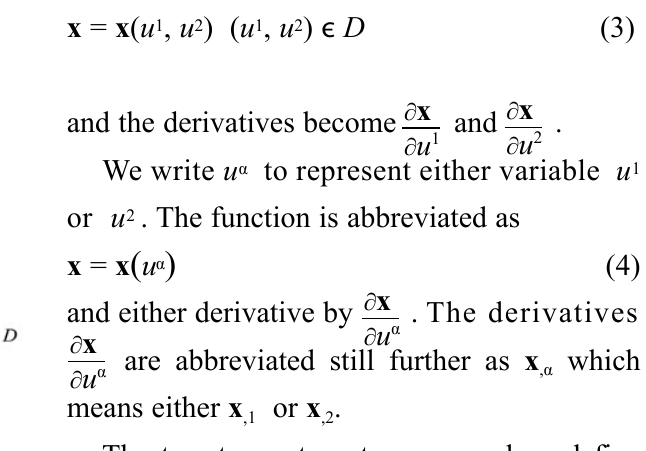
Figure 1 Graphical representation of a vector function of two variables (equation 1). The function generates a surface in space. Along the curve labelled v the parameter v is fixed and parameter u varies; it is a u- parameter curve. Similarly along the curve labelled u parameter u is fixed; it is a v- parameter curve. The surface has two families of curves, the u- and the v- parameter curves. x is the position vector of the point on the surface with parameters u and v.